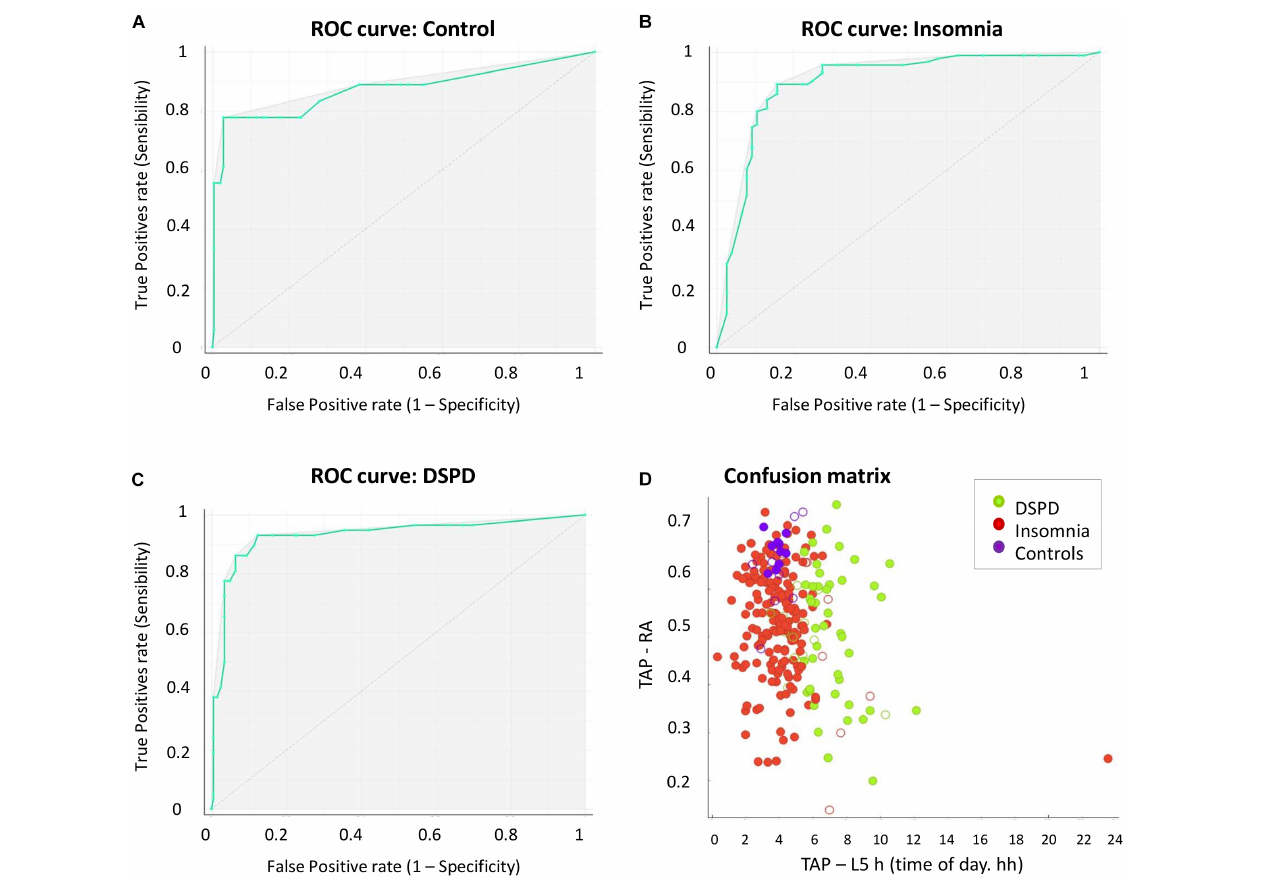
FIGURE 5 | ROC curves for healthy controls (A) , insomnia (B) , and DSPD (C) . (D) The graphical representation of the confusion matrix data, as a function of the attributes TAP-RA (ranging from 0 to 1, Y -axis) and TAP-L5h (time of day, X -axis). Solid dots indicate true positives, and empty dots indicate false negatives. Cases classified as DSPD (green dots) were characterized by later mid-sleep time (TAP-L5h) than the other classes, while their TAP-RA scored within a wide range. Insomnia (red dots) exhibited a mid-sleep time between 3:00 and 5:00 h and, as in the case of DSPD, a wide range of TAP-RA scores. Healthy controls showed a mid-sleep time primarily centered around 4:00 h and predominantly high values of TAP-RA